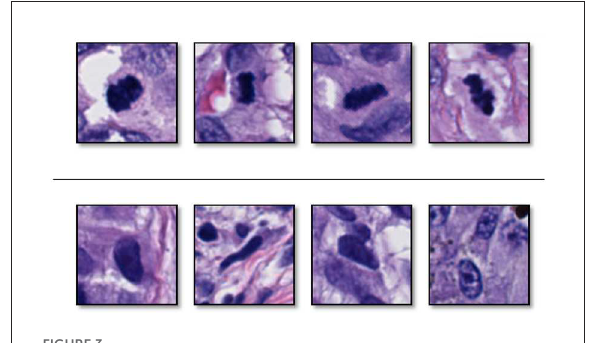
FIGURE3 Examples of (top) sampled mitoses, and (bottom) sampled nuclei that are not mitoses. These two entities have similarity in color, surrounding, and texture (Reprinted by permission from Elsevier, Computerized Medical Imaging and Graphics, “Machine learning techniques for mitoses classification,” S. Nofallah, S. Mehta, E. Mercan, S. Knezevich, C. J. May, D. Weaver, D. Witten, J. G. Elmore, L. G. Shapiro, Copyright Elsevier 2021.).